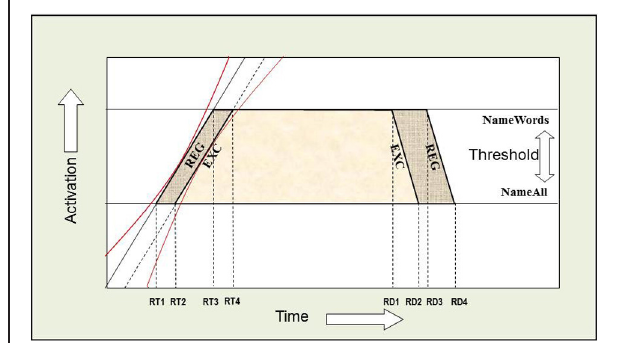
FIGURE 13 | Additive joint effects on RT and RD between INST and WT. An Additive Factors Method (AFM) interpretation of the additive effect on RT is that INST and WT are affecting separable systems in time. If INST are assumed to affect the threshold for activation (i.e., the amount of time it takes to verify that a letter string spells a word), and WT is assumed to shift the rate of activation over time (i.e., the time it takes to choose among the competing phonological codes for EXCs), or vice versa, then the points in time when each rate crosses a threshold correspond to the average onset RTs (the left side of each trapezoid). The red confidence intervals around the slopes allow for trial to trial variation as described by Masson and Kliegl (2012), and thus we note that such variation is not problematic for applying the AFM, and can be easily accommodated by cascaded stages of processing. The effects of INST and WT on RD represent a dissociation when compared to RT. The right side of each trapezoid represents the RD and illustrates the